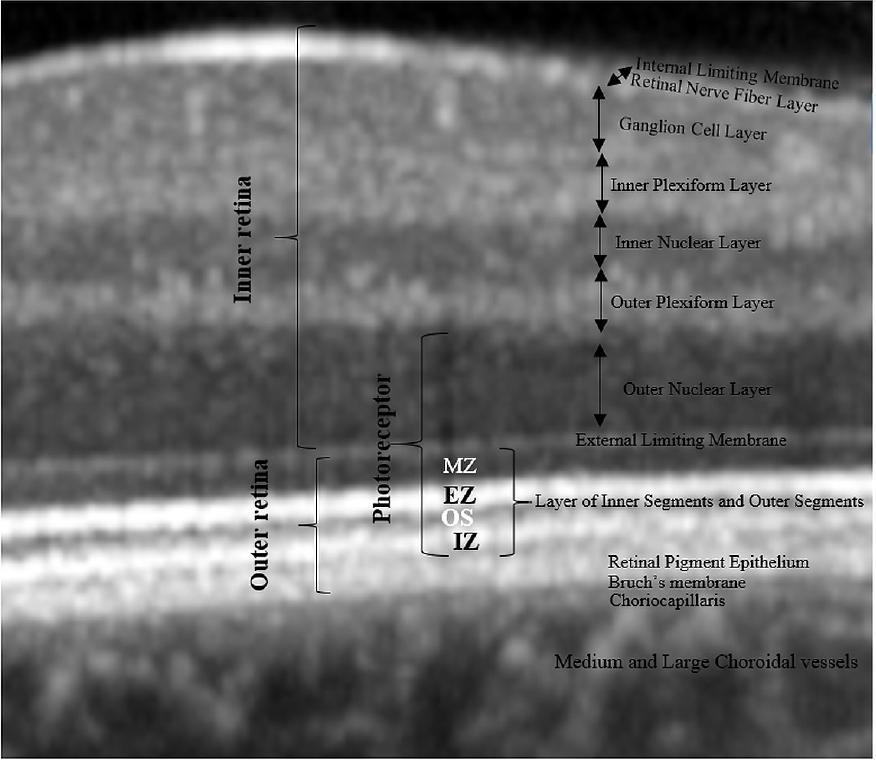
Figure 2. Retinal layer segmentation. MZ, myoid zone; EZ, ellipsoid zone; OS, outer segment; IZ, interdigitation zone.